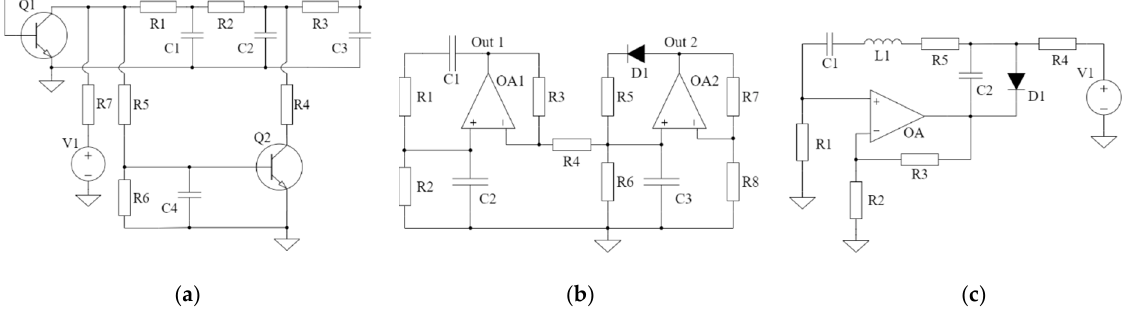
Figure 2. Circuit diagrams of the RC1 chaos oscillator ( a ), RC2 chaos oscillator ( b ), Vilnius chaos oscillator ( c ) [14–17].